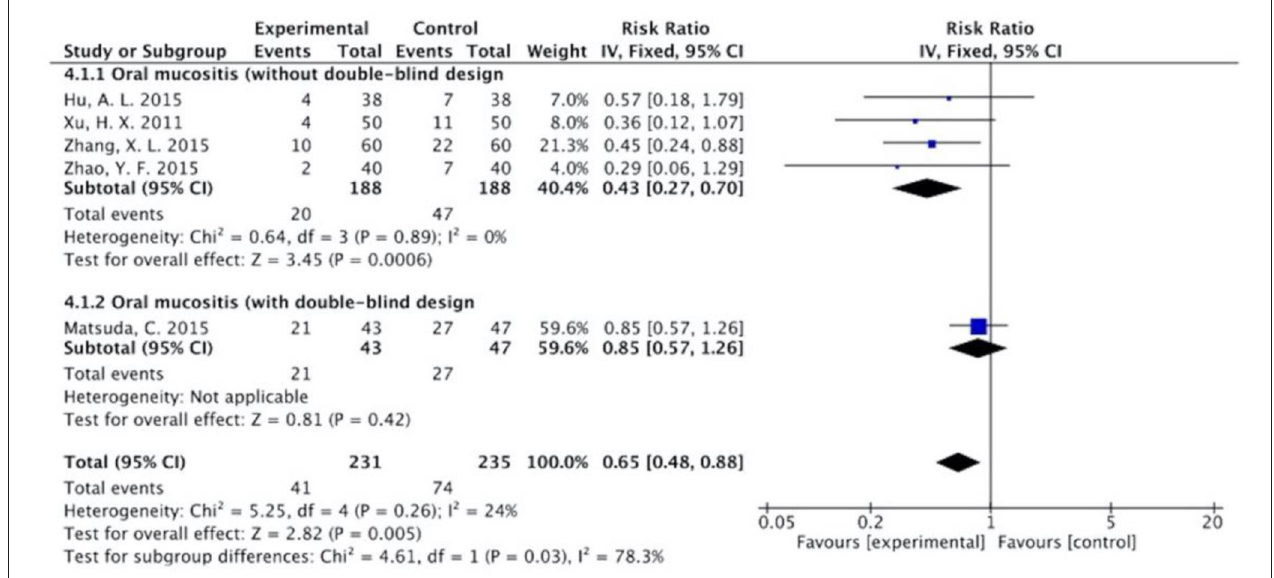
FIGURE 10 | Sub-analysis on the effect of herbal medicine in oral mucositis in chemotherapy-induced toxicity.